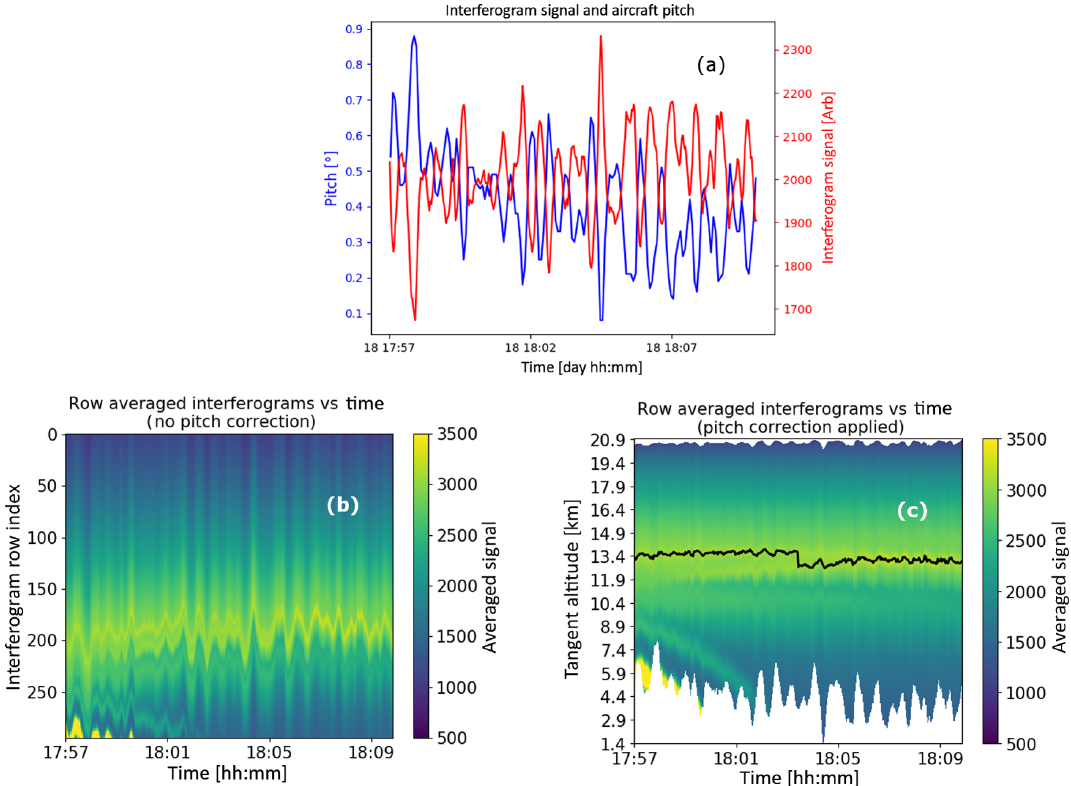
Figure 13. Example of the correction for the airplane pitch variation. The interferogram signal at a single pixel plotted with the pitch variation as a function of time is shown in (a) . The average signal at each interferogram row plotted as a function of row number and stacked as a function of time is shown in (b) . The average signal at each interferogram row corrected for pitch variation and plotted as a function of tangent altitude and stacked as a function of time is shown in (c) and the solid black line is described in the